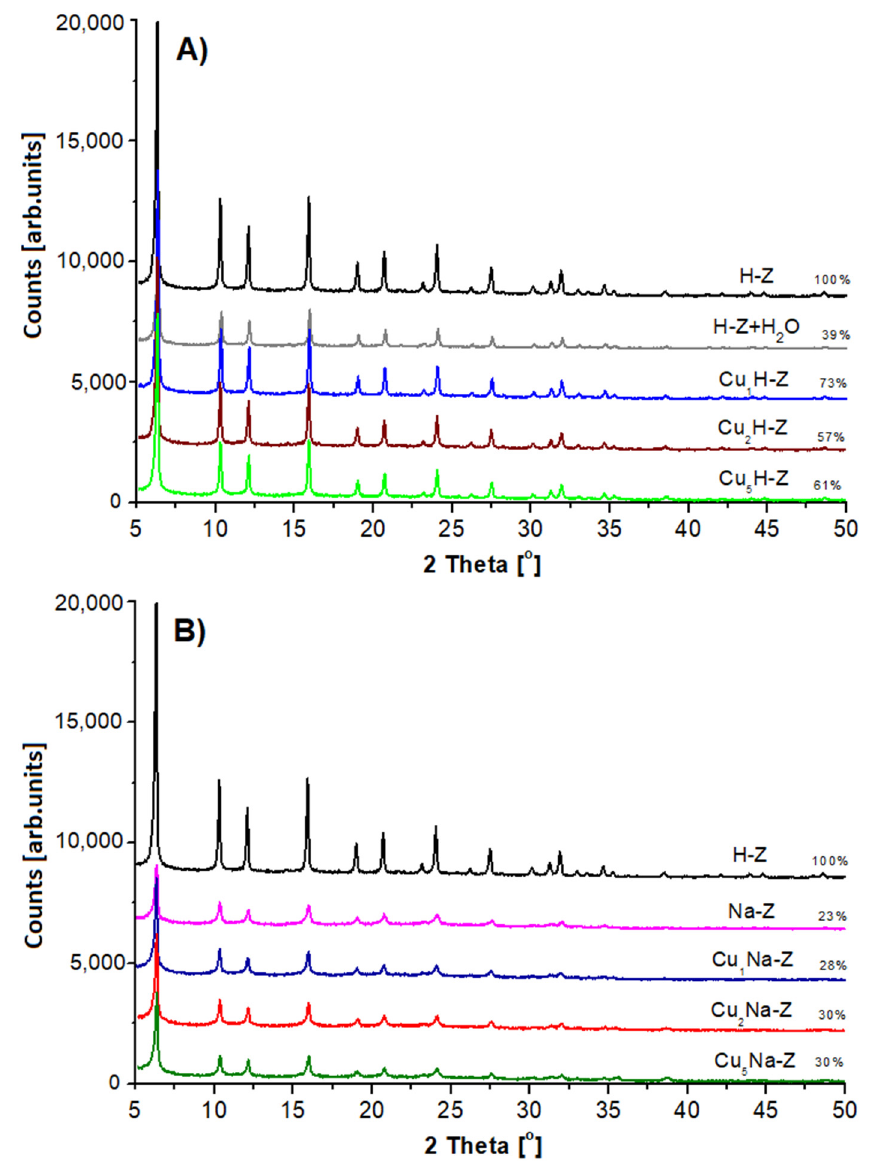
Figure 2. Powder XRD patterns of modified zeolites: ( A ) samples modified only with Cu(NO 3 ) 2 ·3H 2 O; ( B ) samples pretreated with NaNO 3 and then modified with Cu(NO 3 ) 2 ·3H 2